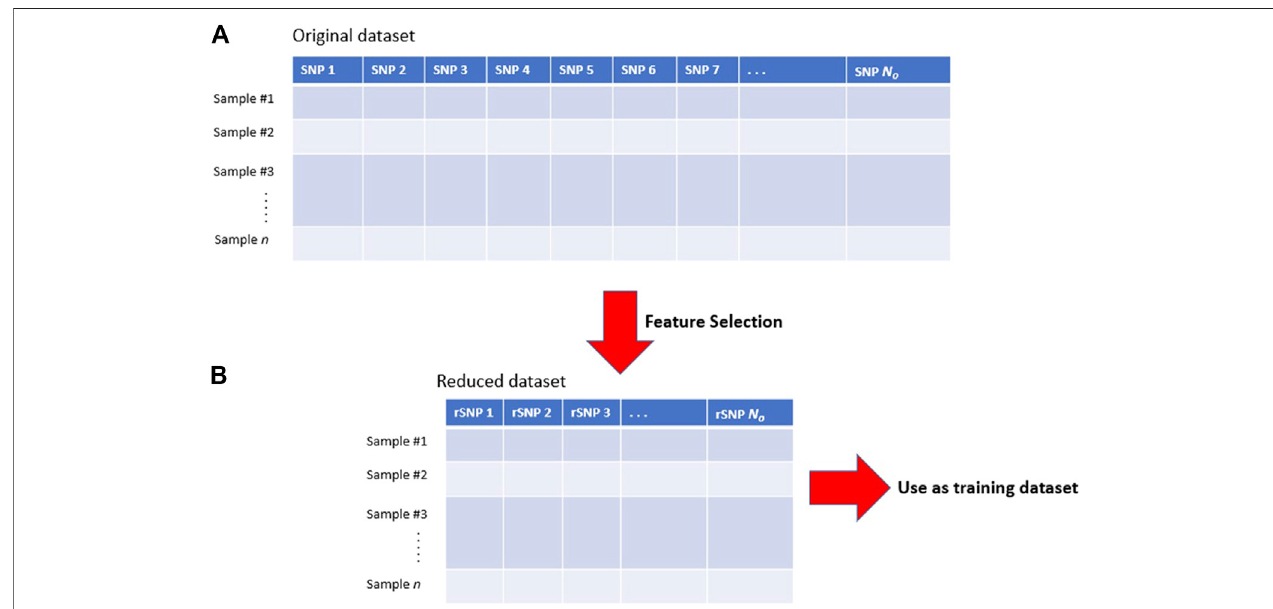
FIGURE 2 | Illustration of feature selection process. (A) The original dataset may contain an excessive number of features and a lot of irrelevant SNPs. (B) Feature selectionreducesthedimensionalityofthedatasetbyexcludingirrelevantfeaturesandincludingonlythosefeaturesthatarerelevantforprediction.Thereduceddataset contains relevant SNPs (rSNPs) which can be used to train the learning algorithm. N o : original number of features, N r : number of remaining relevant